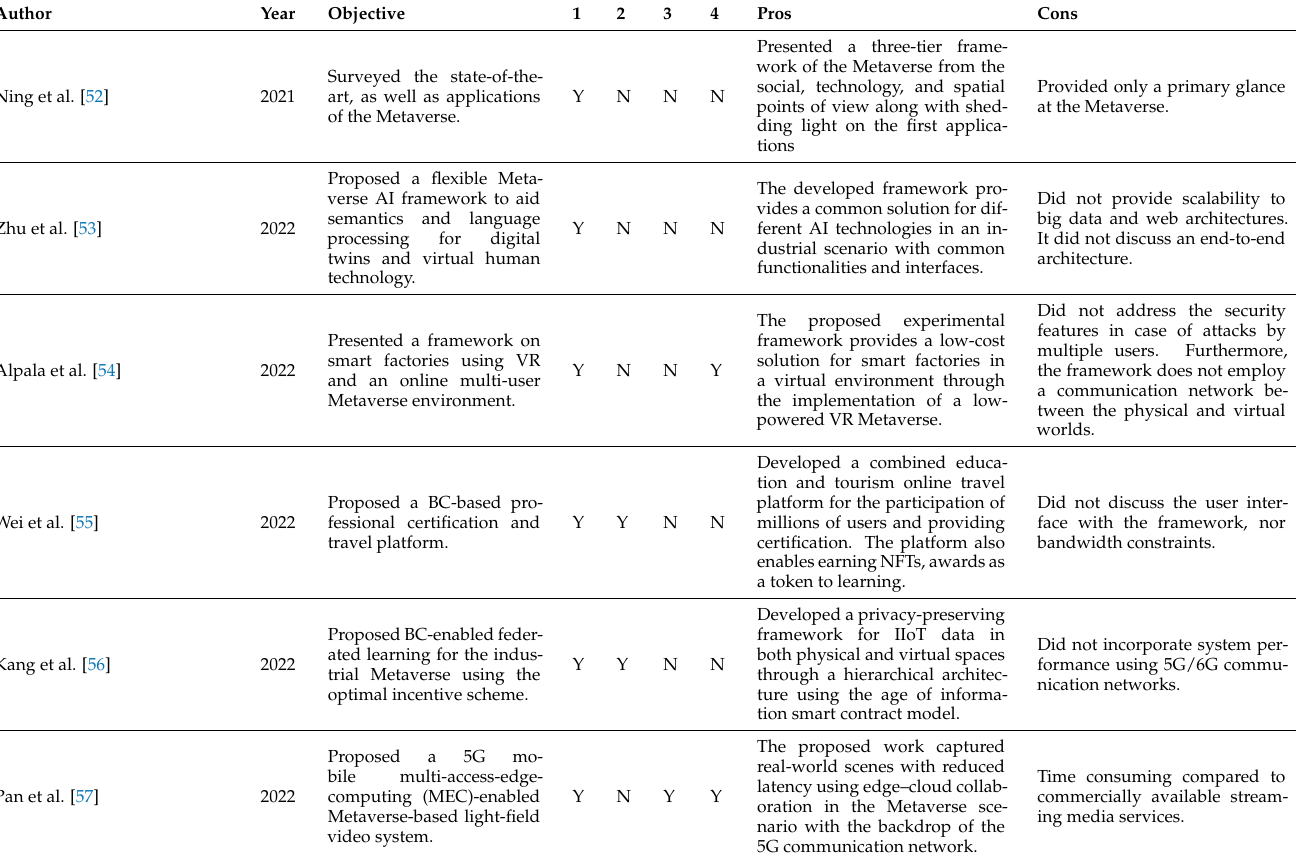
Table 4. Comparison of existing state-of-the-art research and the proposed